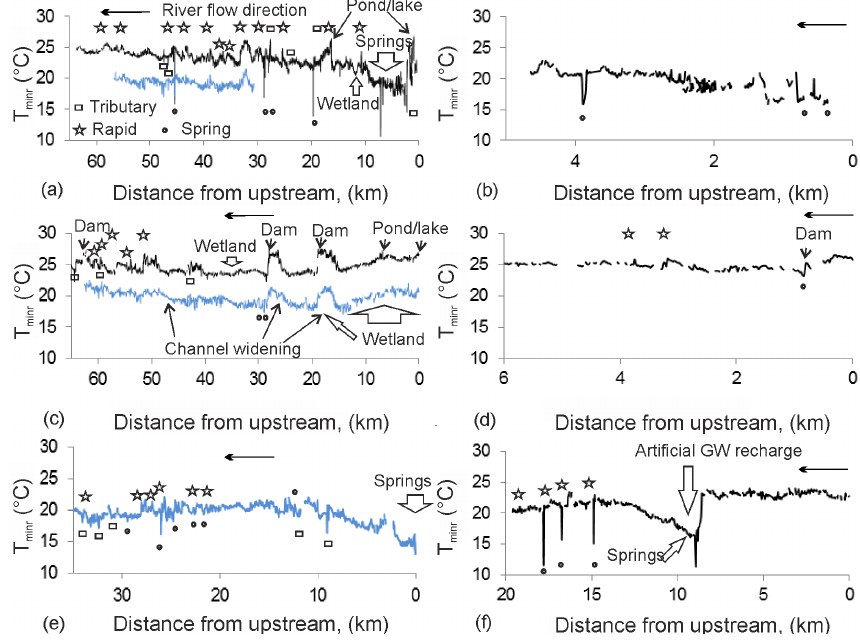
Figure 5. Longitudinal profiles of T minr of the rivers Vantaa (a) , Herajoki (b) , Keravanjoki (c) , Tuusulanjoki (d) , Lepsämänjoki (e) and Palo- joki (f) in 2010 (black line) and 2011 (blue line). Notable tributary confluences, GW–SW exchange, dams, rapids and channel morphology changes are marked in